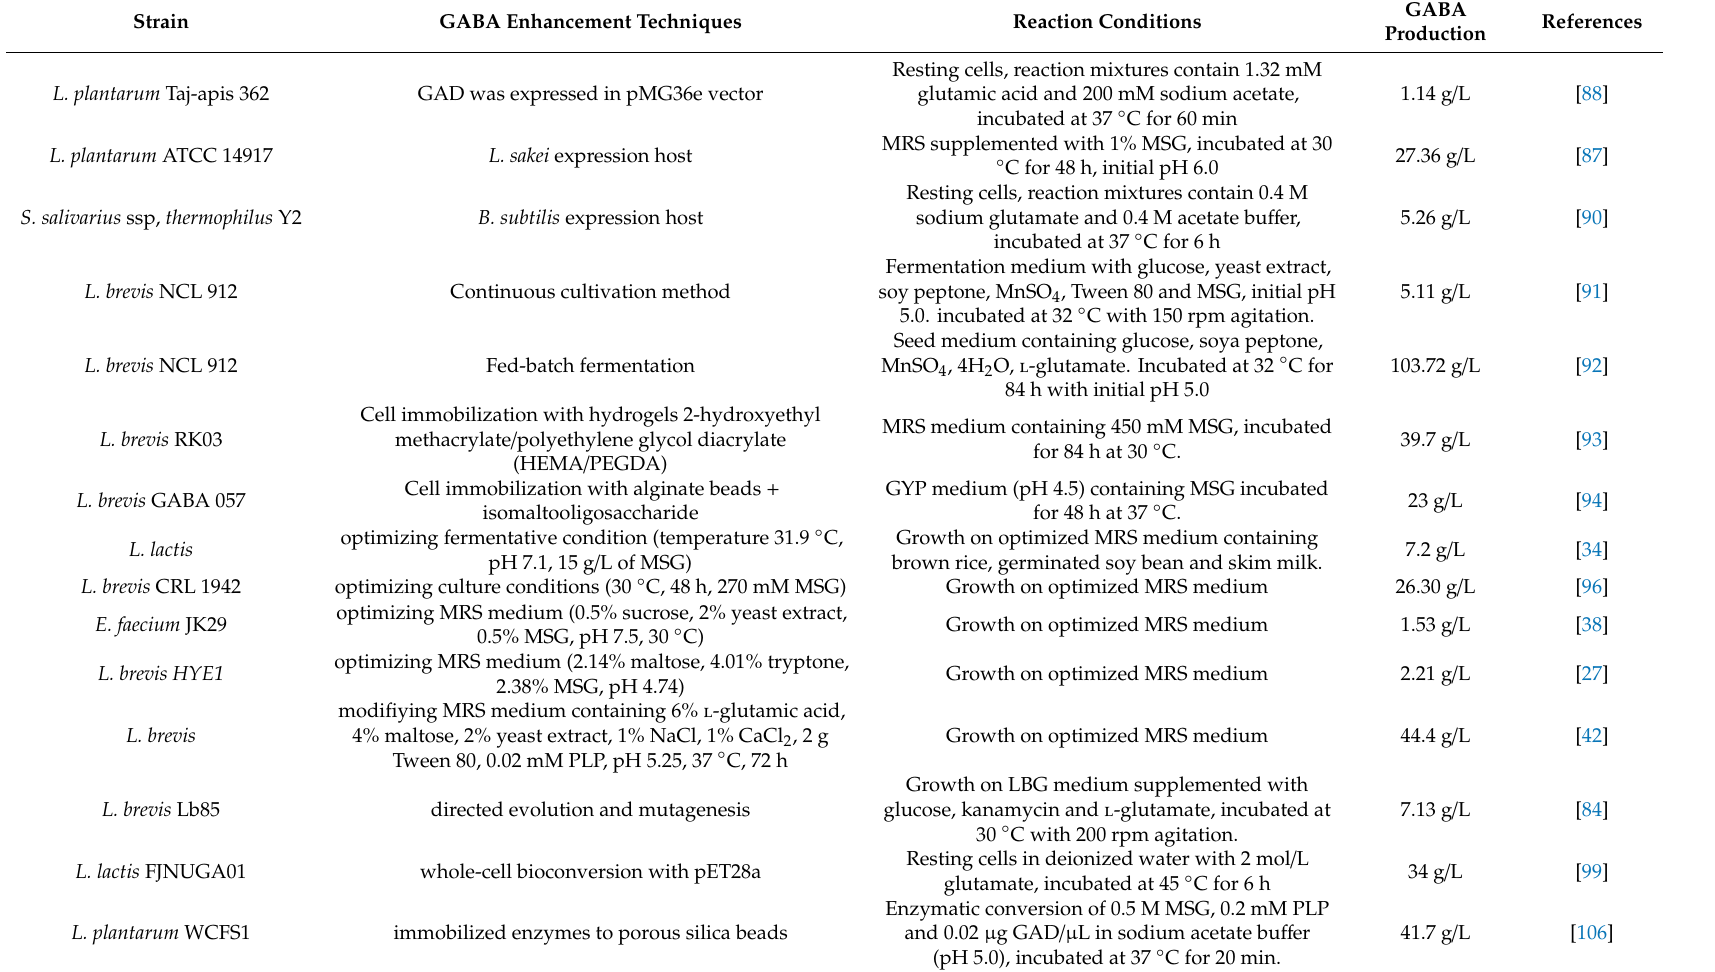
Table 3. Various approaches to improve GABA